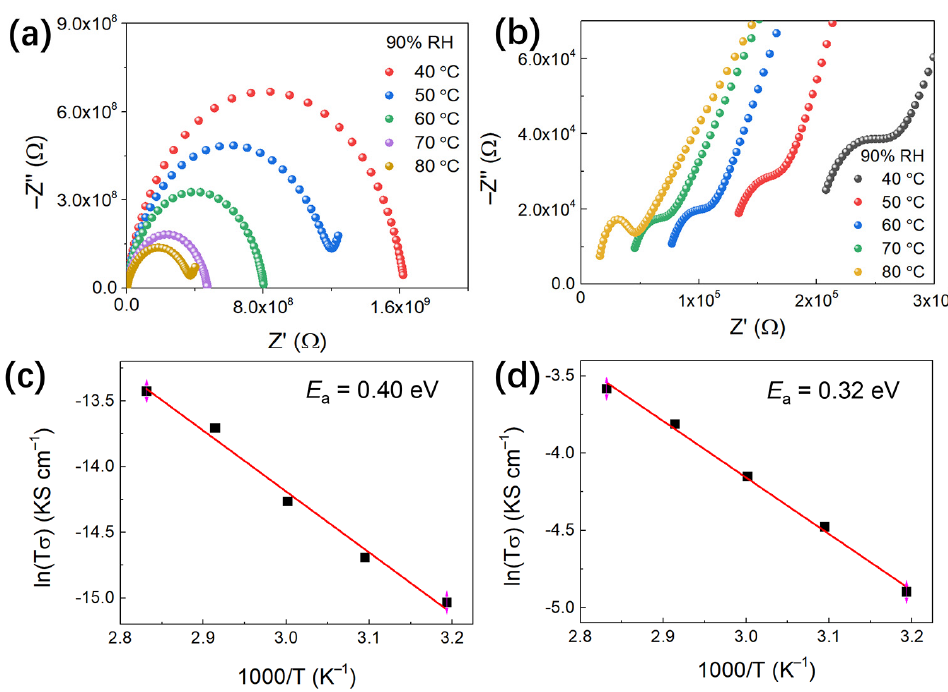
Figure 5. Nyquist plots of ( a ) ZnBPD-4F4TS and ( b ) NH 4 Br@ZnBPD-4F4TS at different tempera- tures (from 40 to 80 °C) and 90% RH. Dependence of proton conductivity in ( c ) ZnBPD-4F4TS and ( d ) NH 4 Br@ZnBPD-4F4TS as a function of temperature at 90% RH. ( d ) NH 4 Br@ZnBPD-4F4TS as a function of temperature at 90%